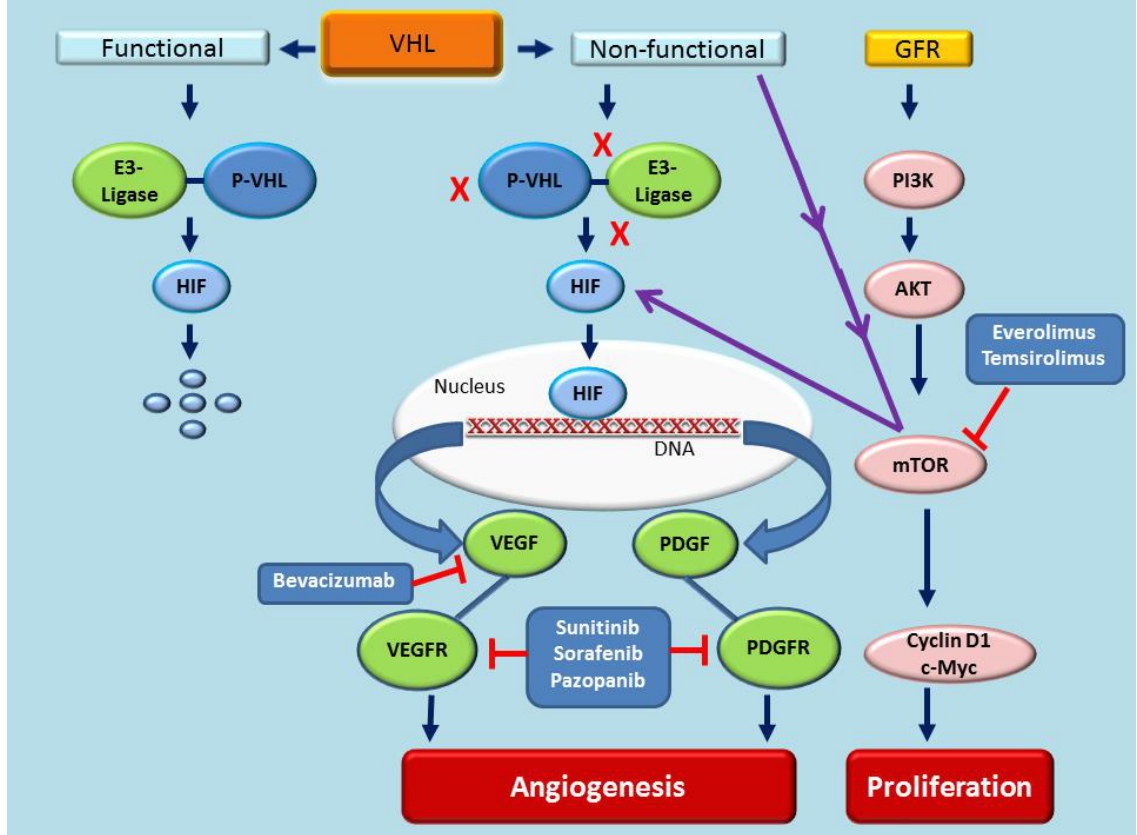
Figure 1.The role of VHL and mTOR in angiogenesis and proliferation of RCC. A non-functional VHL is the major risk factor for the development and progression of RCC. The functional protein of VHL, pVHL, complexes with E3-ligase and degrades HIF. When the VHL is non-functional, HIF is stabilized and translocated to nucleus where it binds with HIF responsive elements of the DNA and activates many pro-angiogenic factors including VEGF and PDGF. They interact with their respective tyrosine kinase receptors VEGFR (mostly at endothelial cells) and PDGFR (mostly at vascular smooth muscle cells and pericytes) and promote angiogenesis. The PI3K/AKT/mTOR pathway is activated by many factors including growth factor receptors. mTOR in turn activates cyclin D1 and cMyc and promotes cell proliferation and survival. Furthermore, VHL inactivation also activates mTOR, which in turn up-regulates HIF and subsequent angiogenesis. GFR, growth factor receptor; HIF, hypoxia- inducible factor; PDGF platelet-derived growth factor; PDGFR, receptor for PDGF; VEGF, vascular endothelial growth factor; VEGFR, receptor for VEGF; VHL,von Hippel Lindau